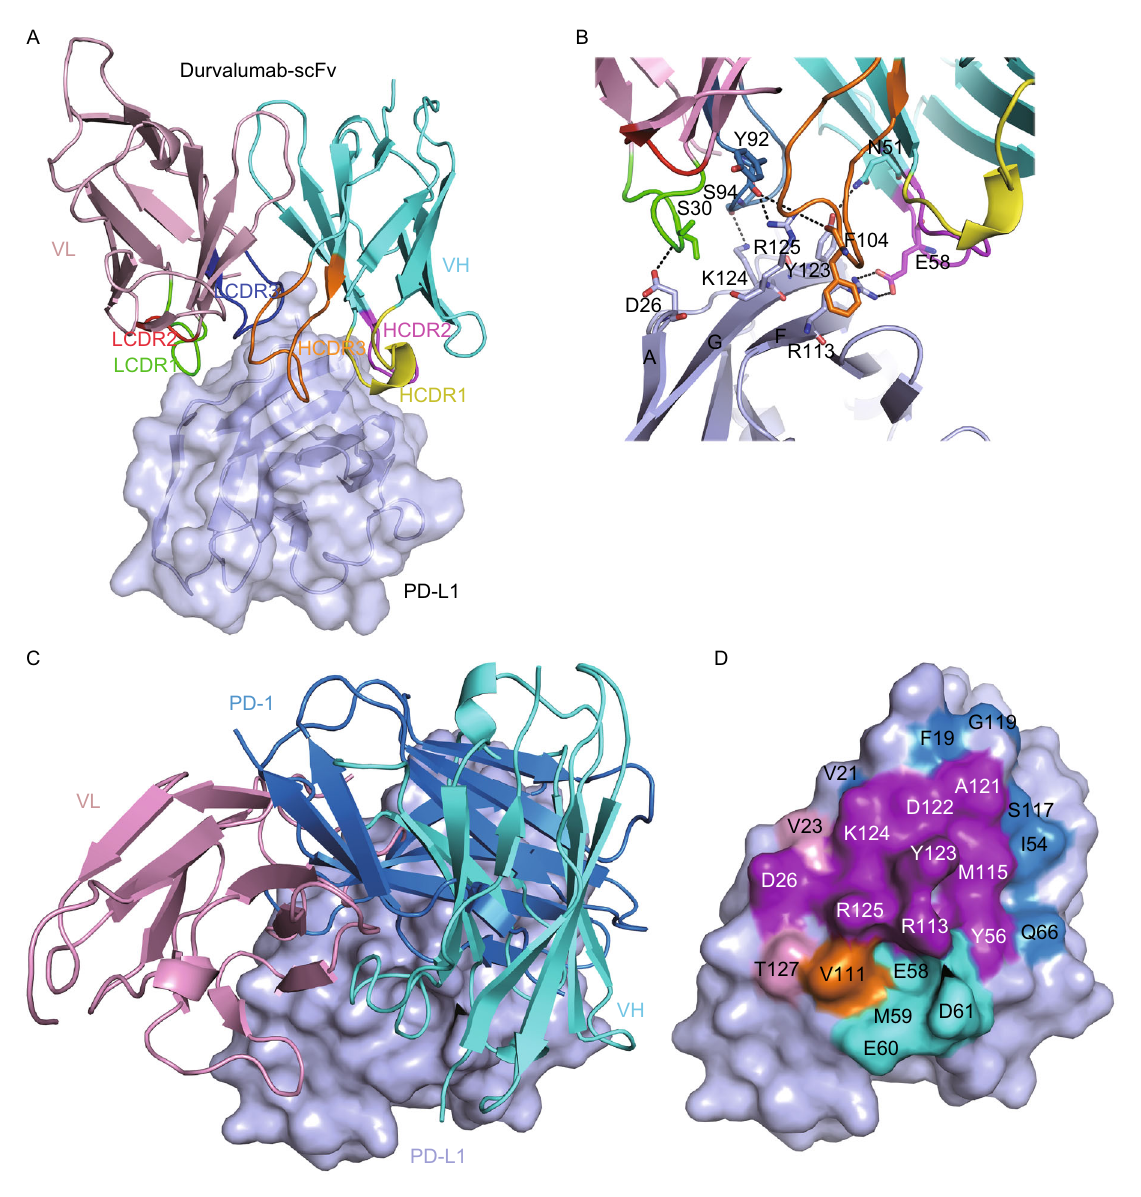
Figure 1. Structural basis of durvalumab-based binding to PD-L1 and intervention of the PD-1/PD-L1 interaction . (A) Overall structure of durvalumab-scFv/PD-L1 complex. The MAb-binding IgV domain of PD-L1 is shown as surface diagram in light blue, and the heavy (VH) and light chains (VL) of scFv are shown as cartoon representations in cyan and light pink, respectively. The CDR1, CDR2, and CDR3 loops of VH are colored in yellow, magenta and orange, respectively. The CDR1, CDR2, and CDR3 loops of VL are colored in green, hot pink and blue, respectively. (B) Detailed interactions in the durvalumab-scFv/PD-L1 interface. Residues involved in the hydrogen bond interaction are shown as sticks and labeled. Hydrogen bonds are shown as dashed lines. (C) Superimposition of the durvalumab-scFv/PD-L1 complex structure with the PD-1/PD-L1 complex structure (PDB: 4ZQK). PD-1 is shown in marine, PD-L1 as a surface diagram in light blue, and durvalumab-scFv VL in light pink, VH in cyan, respectively. (D) Binding surface on PD-L1 for PD-1 or durvalumab. The binding residues of PD-1 on PD-L1 are colored in marine, whereas residues contacted by the durvalumab-scFv VH or VL are colored in cyan or light pink, respectively, and the overlapping residues bound by both the receptor PD-1 and durvalumab are colored in